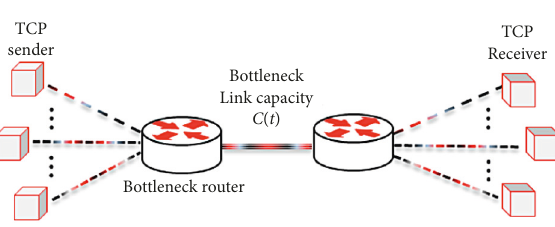
Figure 1: TCP network